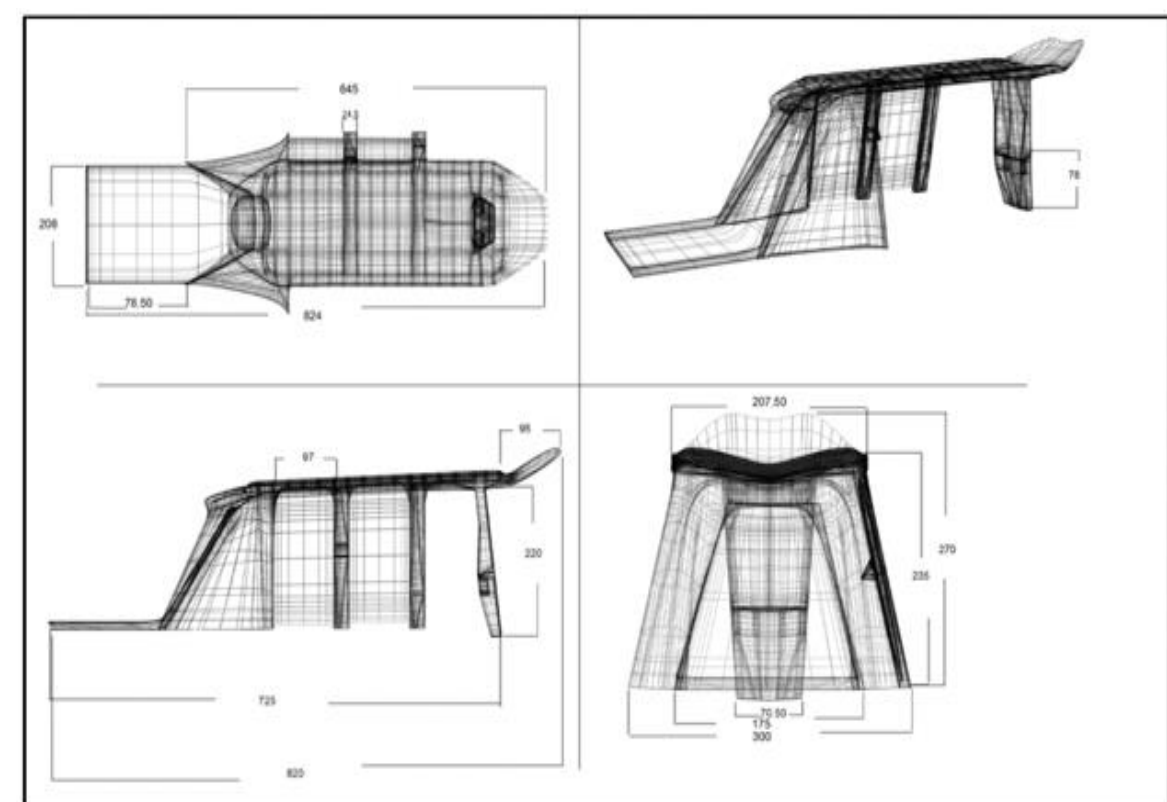
Figure 7. Smart stop system dimensioning presentation board (Original,